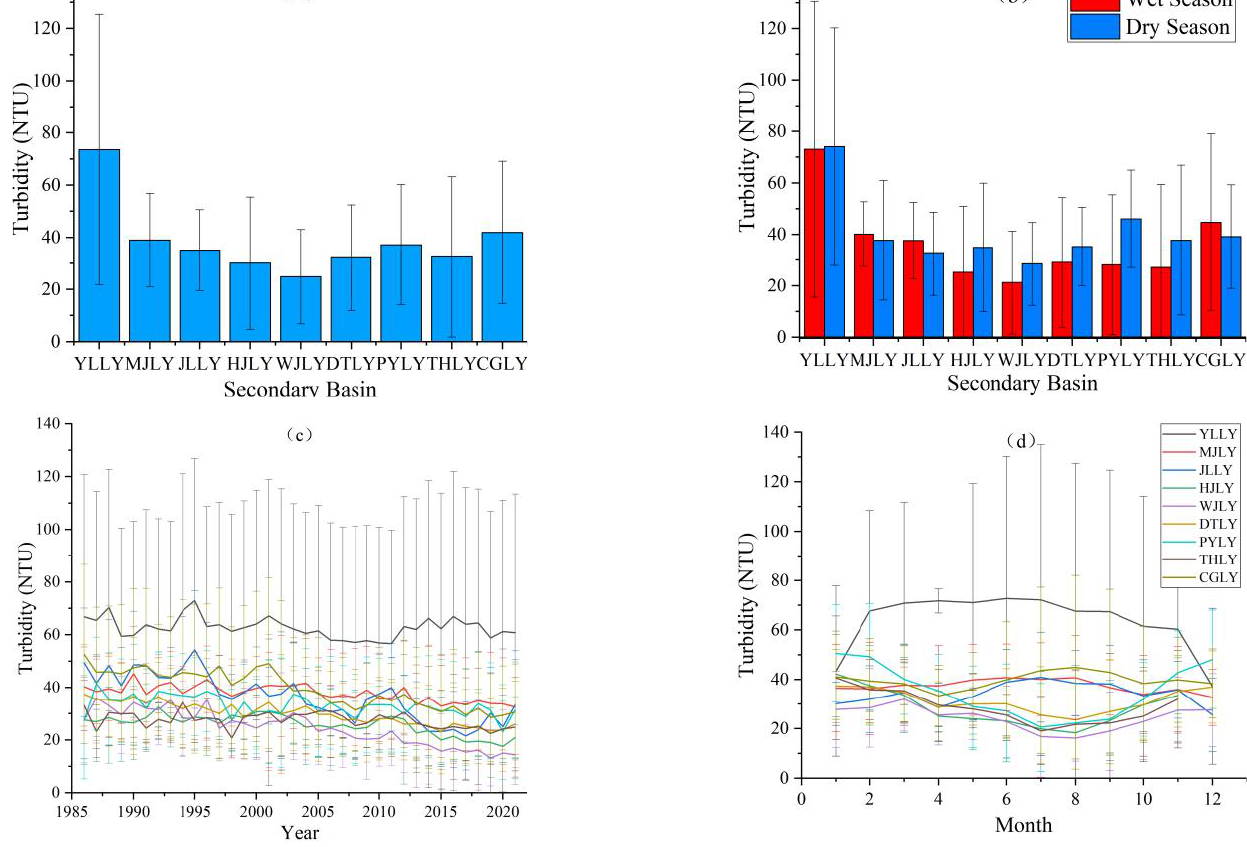
Figure 10. Distribution and variation of mean turbidity in the secondary basins in the Yangtze River Basin from 1986 to 2021. ( a ) mean of 36 years; ( b ) mean of wet season and dry season; ( c ) annual variations; ( d ) monthly variations.